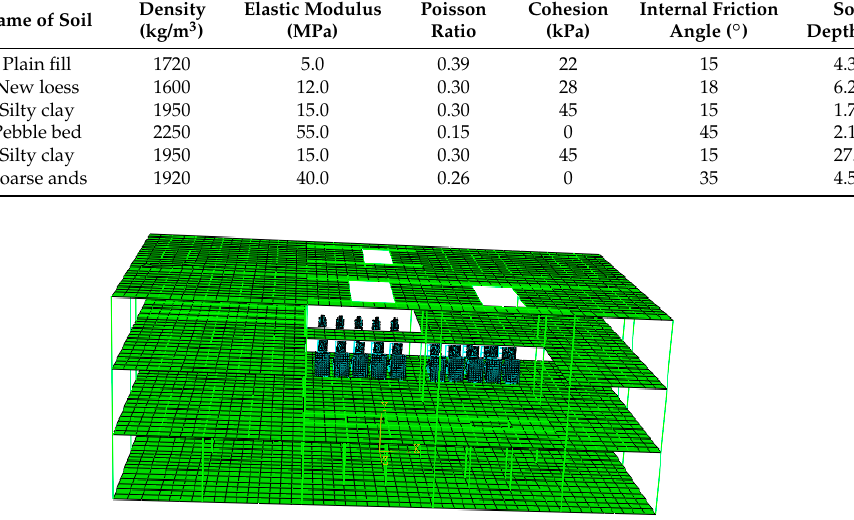
Figure 6. Finite element model of a substation.